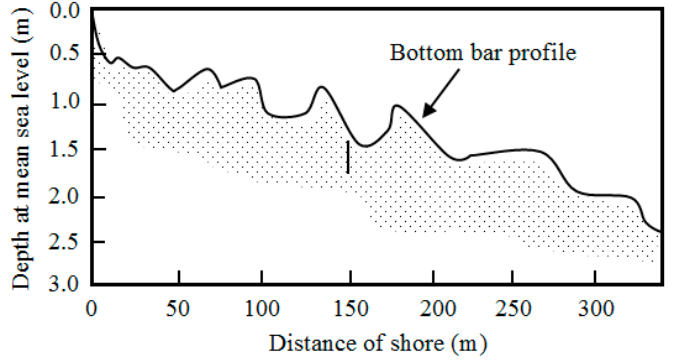
Figure 1. Bottom bar profile in Chesapeake Bay (adapted from [1]).